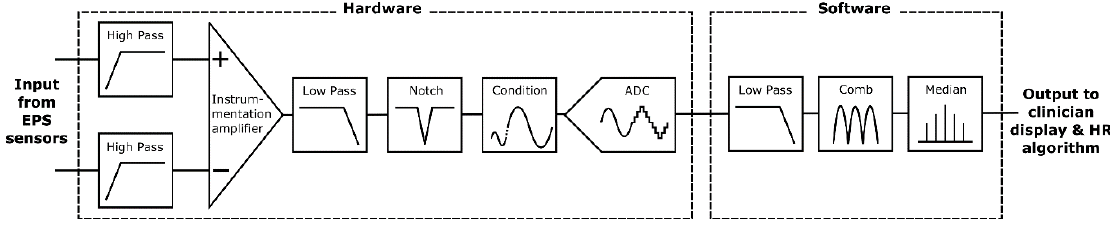
Figure 6. Filtering stage block diagram.